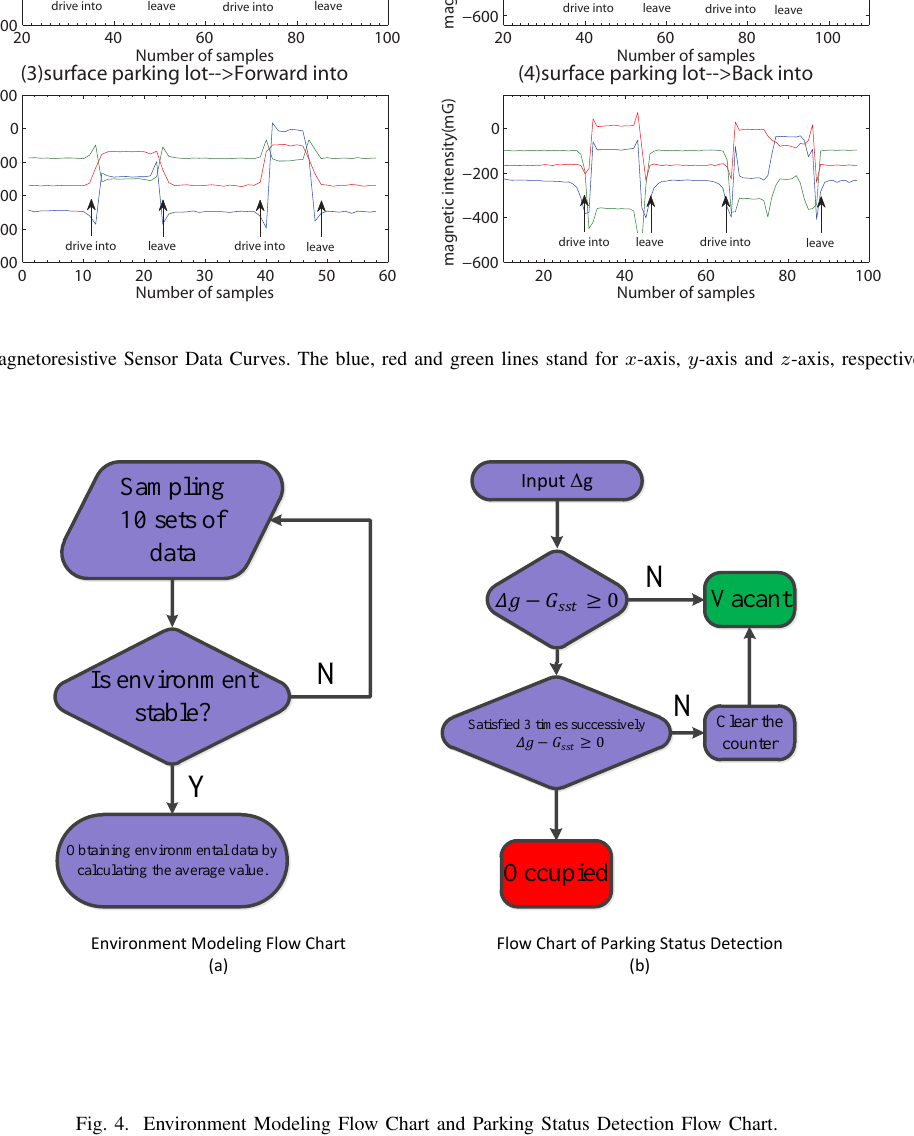
Fig. 4. Environment Modeling Flow Chart and Parking Status Detection Flow